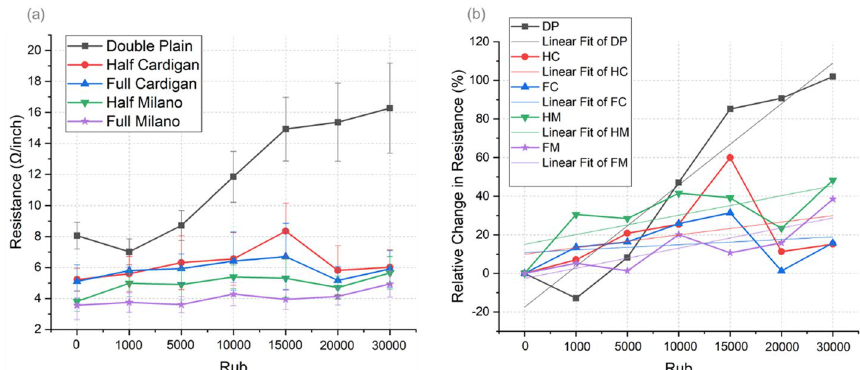
Fig. 9 a Resistance value (unit: Ω) in the direction of the weft in different knitted textiles before and after abrasion from 1000, 5000, 10,000, 15,000, 20,000 and 30,000 rubs and b relative change in resistance (%) and linear regression in the direction of the weft in different textiles after abrasion from 1000, 5000, 10,000, 15,000, 20,000 and 30,000 rubs. Note: DP, double plain; HC, half cardigan; FC, full cardigan; HM, half Milano; and